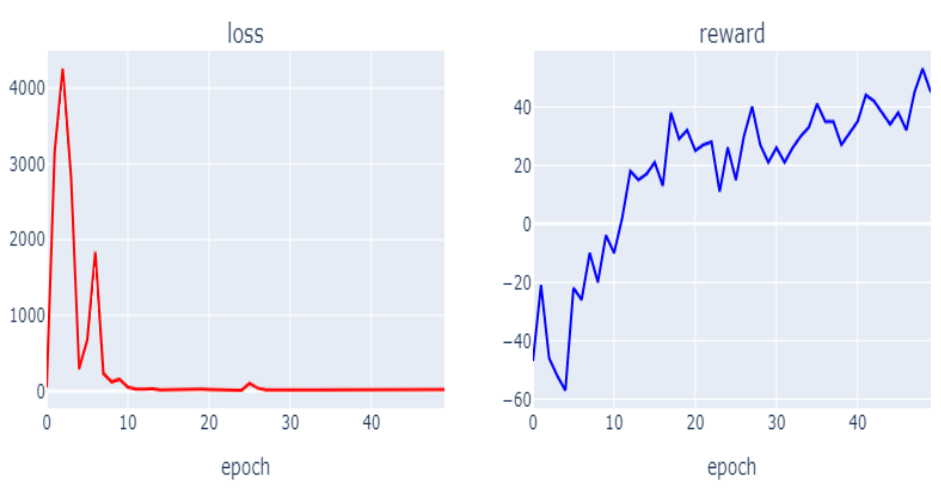
Figure 11. Learning results by substituting the DQN algorithm based on the proposed Total Resource on